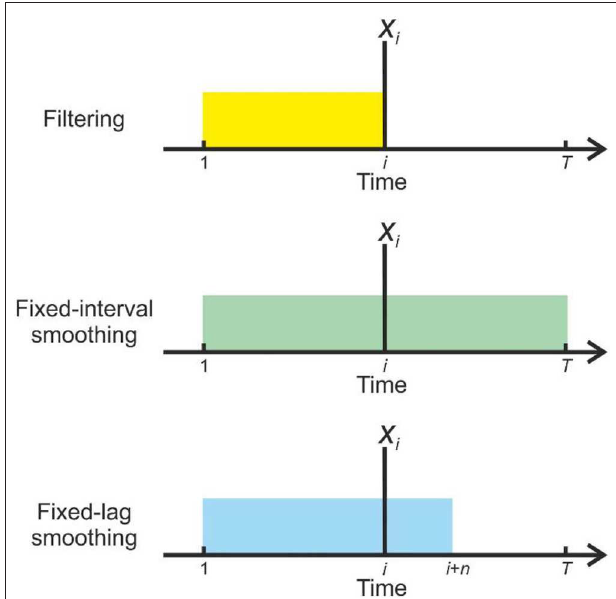
FIGURE 1 | Illustration of the information used by different strategies for inference when forming beliefs about state x at time i (indicated by the vertical line). In filtering (Top) beliefs are based solely on observations made up to and including that time ( o 1 : i ), as indicated by the yellow block, and are not revised in the light of subsequent information (If we assume online inference, then the present time t = i ). In fixed-interval smoothing (Middle) , observations from the whole data set ( o 1 : T ) are used to inform each set of beliefs, as indicated by the green block (Here either t = T or, equivalently, inference is performed offline). In fixed-lag smoothing (Bottom) , beliefs are retrospectively updated up to some fixed lag n , so o 1 : i + n are used (indicated by the blue block) (See Methods for a more formal description, and explanation of the notation) (In this case t = i + n ). Fixed-lag smoothing allows an agent to perform finite retrospective inference, which constitutes a principled trade-off between the reduced inferential accuracy resulting from filtering and the potentially severe computational costs of retrospection to an indefinite temporal